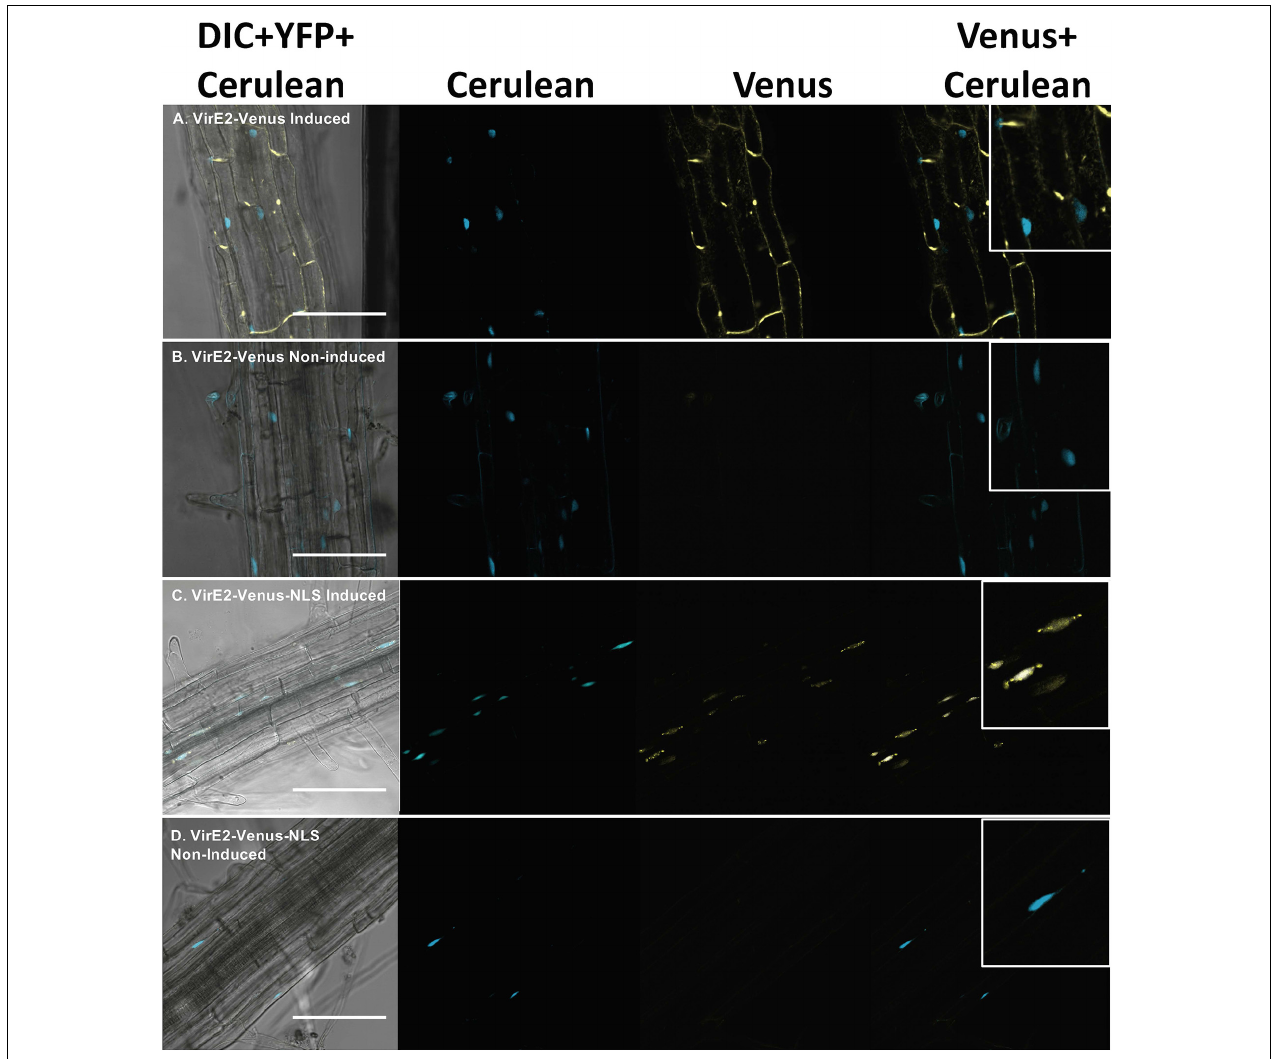
FIGURE 1 | Subcellular localization of VirE2-Venus (A,B) and VirE2-Venus-NLS (C,D) in A. thaliana roots. Transgenic A. thaliana plants expressing inducible VirE2-Venus or VirE2-Venus-NLS were treated with β -estradiol (A,C) or control solution (B,D) . Cerulean-NLS under the control of a CaMV 2 × 35S promoter was used to mark the nuclei. Root cells were imaged by confocal microscopy 9 h after treatment and representative images are shown. Four images of each cell are presented (left to right: Merged DIC + YFP + Cerulean; Cerulean; Venus; merged Venus + Cerulean). Boxes indicate an enlargement of one portion of the merged Venus + Cerulean image. Bars indicate 100 µ